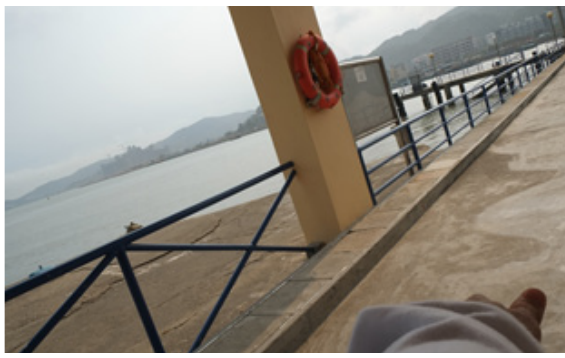
FIGURE 1 | Écho 1 , Jerry Chan, 18 th Mar. 2013 Port de